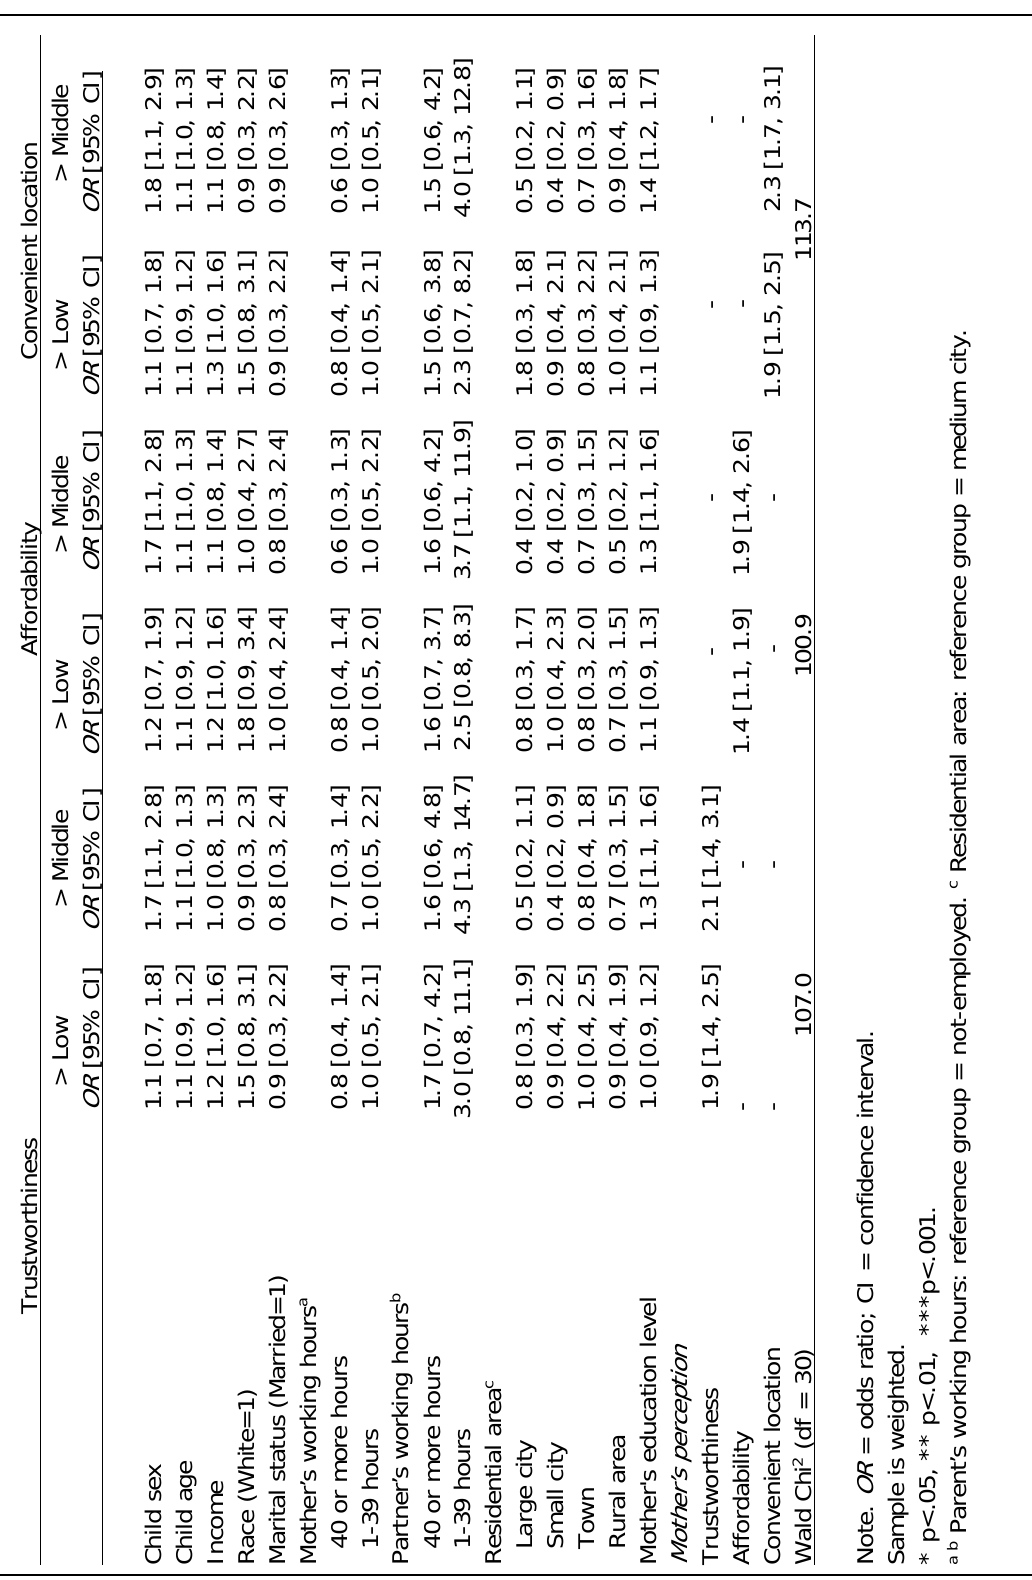
Generalized Ordered Logit Models for Mother Satisfaction using Mother’s